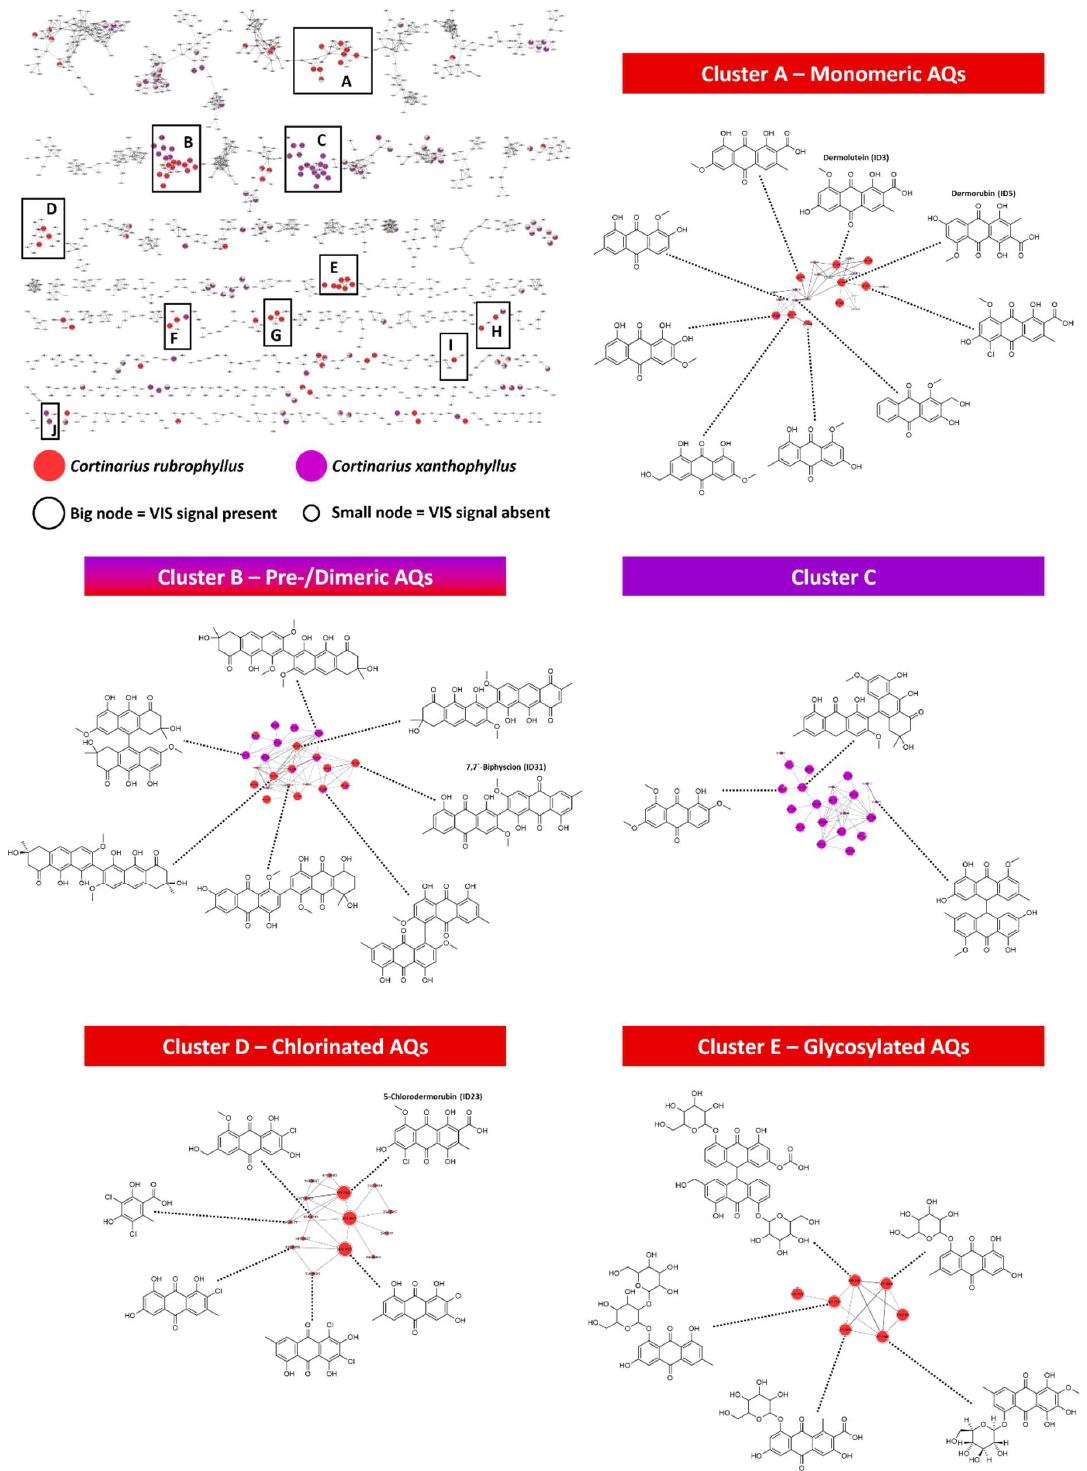
Figure 5. The FBMN with the marked photoactive clusters (A–J) (top left corner) as well as the annotation results for the clusters A–E. Features specific for the active extracts are highlighted as colored nodes: C. rubrophyllus = red, C. xanthophyllus = purple. The node size depicts the features’ ability to absorb visible light: big = “VIS-Signal” present, small = “VIS-Signal” absent. The marker compounds (i.e., dermolutein (ID3), dermorubin (ID5), 5-chlorodermorubin (ID23), and 7,7 (cid:48) -biphyscion (ID31)) are provided with a name on top of the molecular structure. Identification levels are as follows: marker compounds = 1, all other structural suggestions = 2. Refer to the SI for more details of all investigated